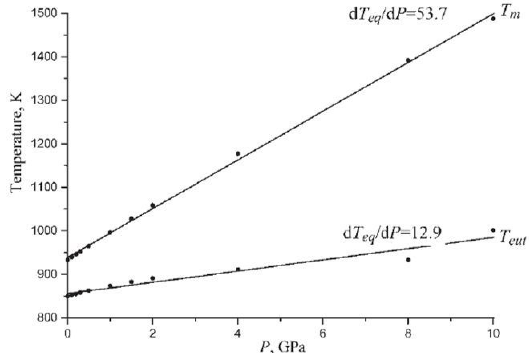
Figure 2. Melting point of aluminum and eutectic temperature of Al-Si system as function of pressure 2